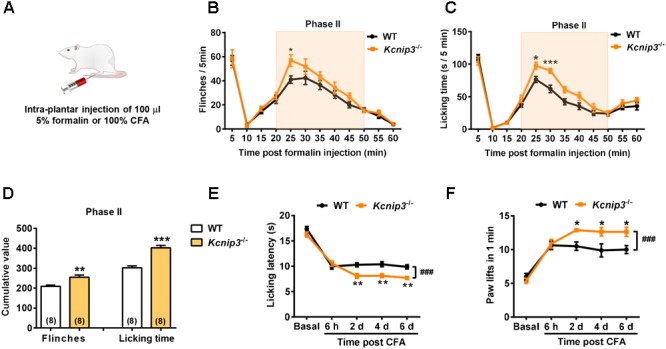
Increased pain sensitivity after intraplantar injection of formalin or complete Freund’s adjuvant (CFA) in Kcnip3-/- rats. (A) Schematic diagram of the establishment of formalin or CFA-induced pain models. (B,C) Flinching counts (B) and licking duration (C) of hindpaw at 5-min intervals for 1 h in the formalin pain model of wild-type and Kcnip3-/- rats. n = 8 for both groups. ∗p < 0.05, ∗∗∗p < 0.001, two-way repeated-measures ANOVA followed by Sidak’s multiple comparisons test. (D) Analysis of the cumulative number of flinching behaviors (left) and licking time (right) of hindpaw in the second phase (20–50 min post injection) of formalin pain model of wild-type and Kcnip3-/- rats. ∗∗p < 0.01, ∗∗∗p < 0.001, unpaired t-test. (E) Time course of hindpaw licking latency in the 52°C hot plate test in the CFA pain model of wild-type and Kcnip3-/- rats. n = 8 for both groups. ∗∗p < 0.01, comparison between the genotypes at the indicated time points; ###p < 0.001, comparison between the two curves, two-way repeated-measures ANOVA followed by Sidak’s multiple comparisons test. (F) Time course of lifting counts of hindpaw in the 4°C cold plate test within 1 min post CFA injection in wild-type and Kcnip3-/- rats. n = 8 for both groups. ∗p < 0.05, comparison between the genotypes at the indicated time points; ###p < 0.001, comparison between the two curves, two-way repeated-measures ANOVA followed by Sidak’s multiple comparisons test.